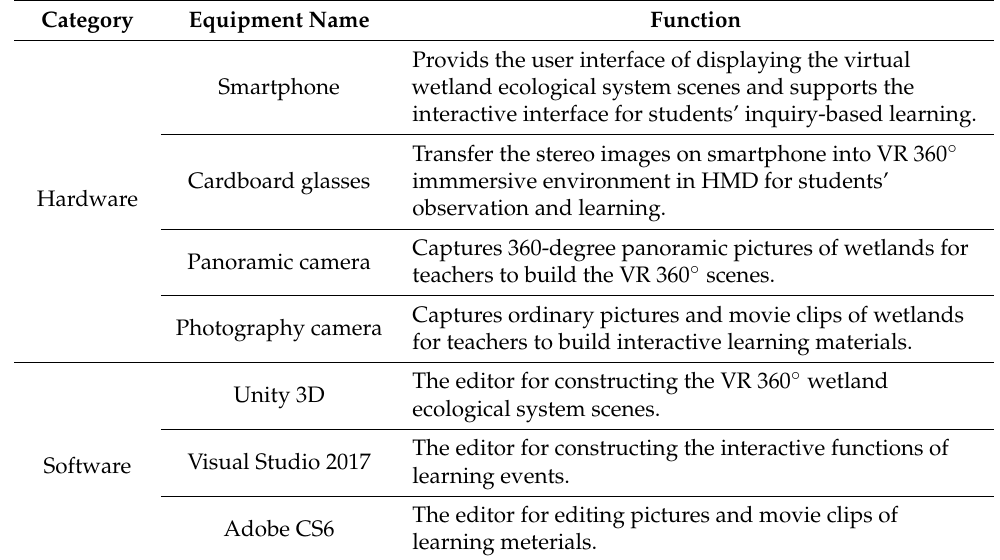
Table 1. The equipment and the functions involved in this study.